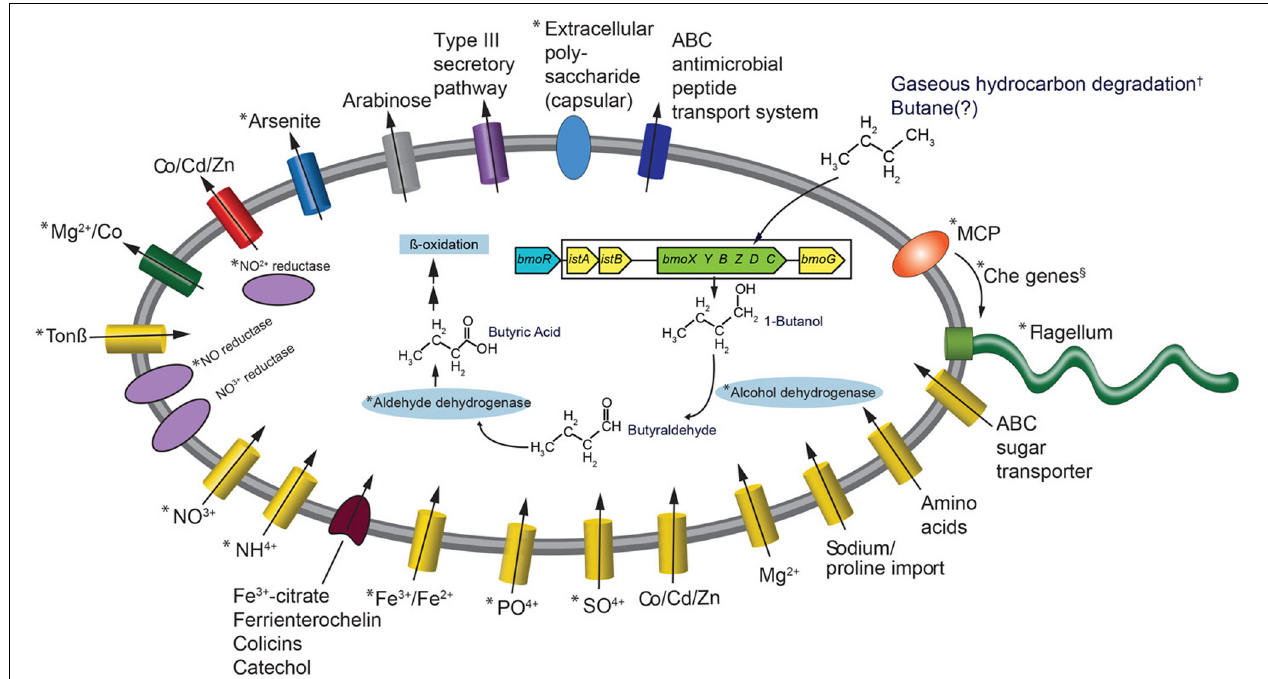
FIGURE 2 | Metabolic reconstruction of the Colwellia SAG. An asterisk indicates Colwellia SAG reads with ≥ 40 bit score to C. psychrerythraea . The BMO operon and adjacent genes (from Kurth et al., 2008, see Figure 1A) are color coded: blue indicates Cowellia SAG. Additionaly, those genes from the DWH plume and sediment metagenomes (Mason et al., 2012, 2014, respectively) are enclosed by rectangle. Genes shown in yellow indicate DWH plume, those in green